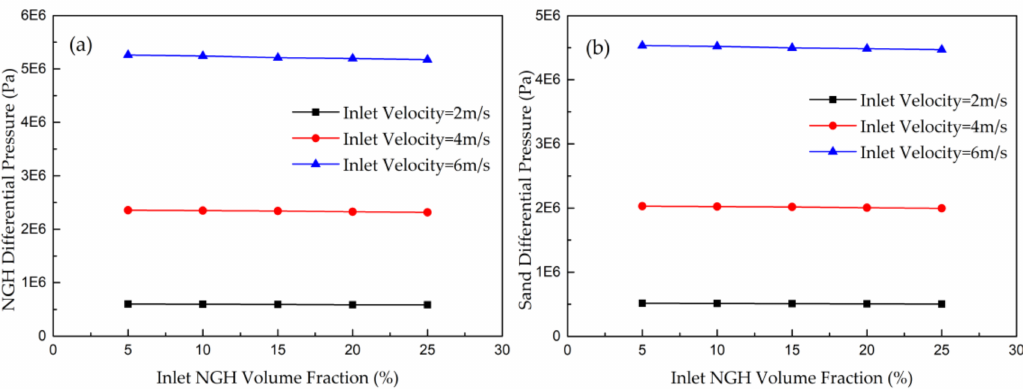
Figure 17. The relationship between inlet NGH volume fraction and di ff erential pressure: ( a ) is for NGH, ( b ) is for